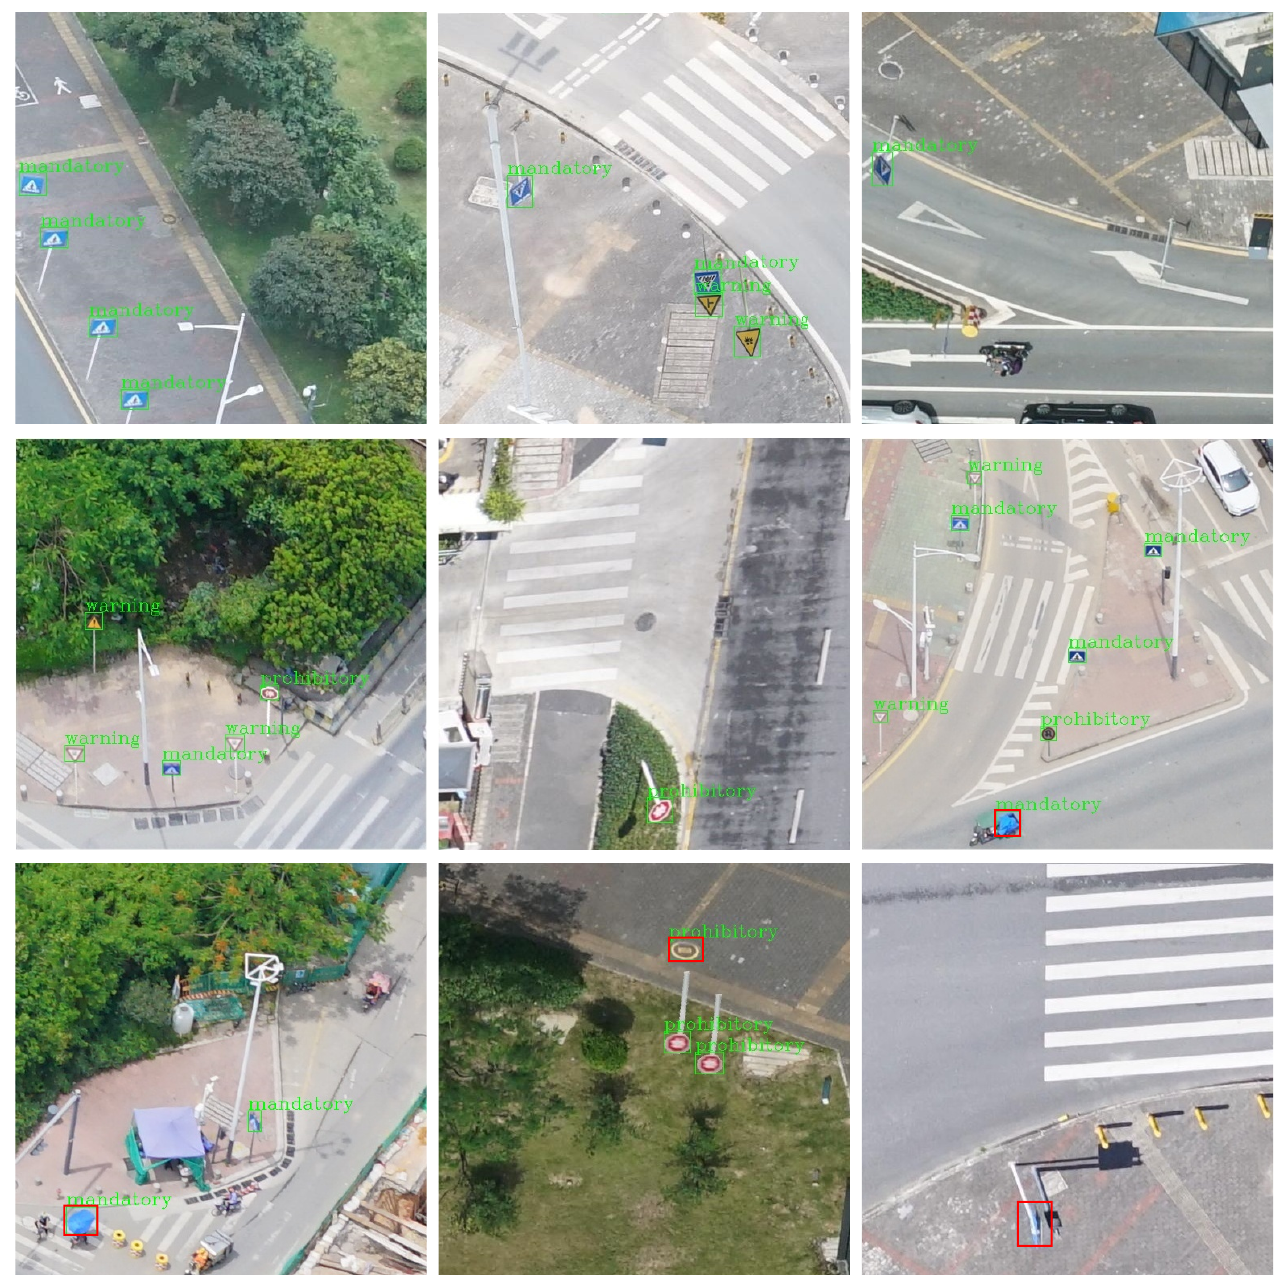
Figure 13. Road sign detection result in cropped oblique aerial images. Green bounding boxes represent TPs, while red boxes represent FPs or FNs. We cropped the images of the detection results to a pixel size of 512 The proposed method obtained an mAP of 93.5%.